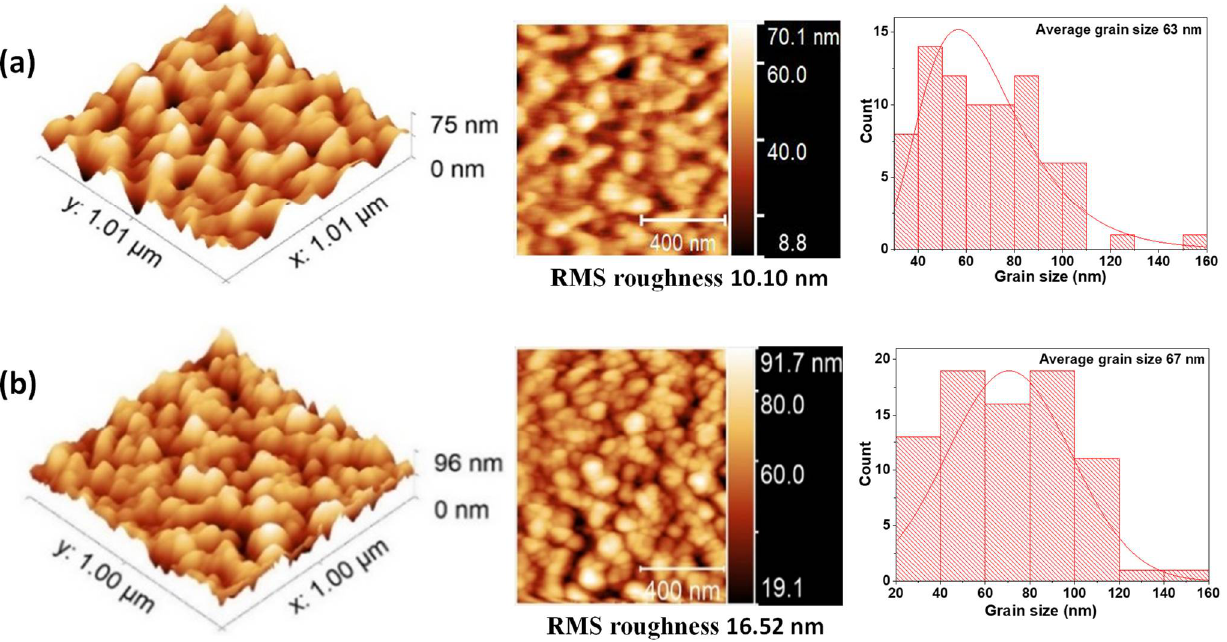
Figure 7. AFM measurements and average grain size for BFO/VO 2 thin films with BFO layers of ( a ) 30 nm and ( b ) 60 nm.